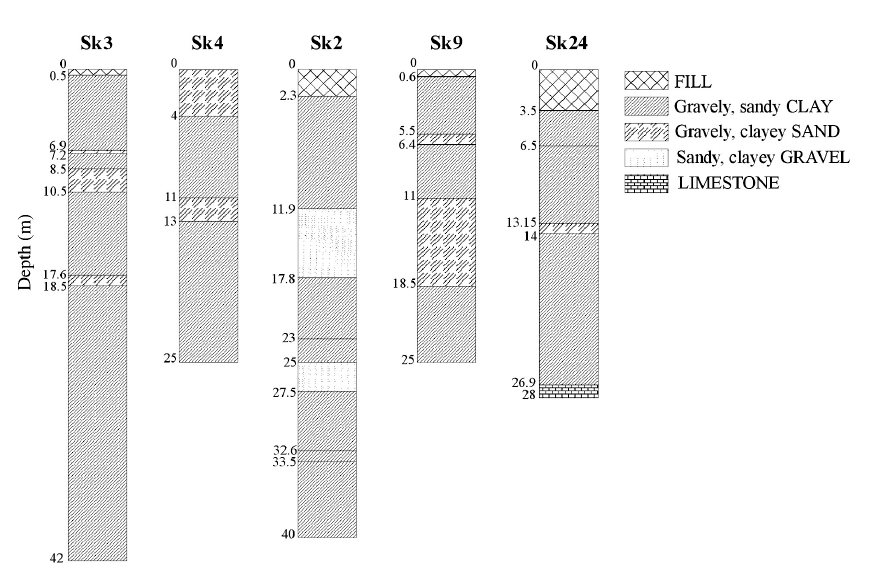
Fig. 4. Boreholes showing typical soil formations in the Dinar Graben. Locations of the boreholes are shown in fig. 2 (after Gullu, 2001).